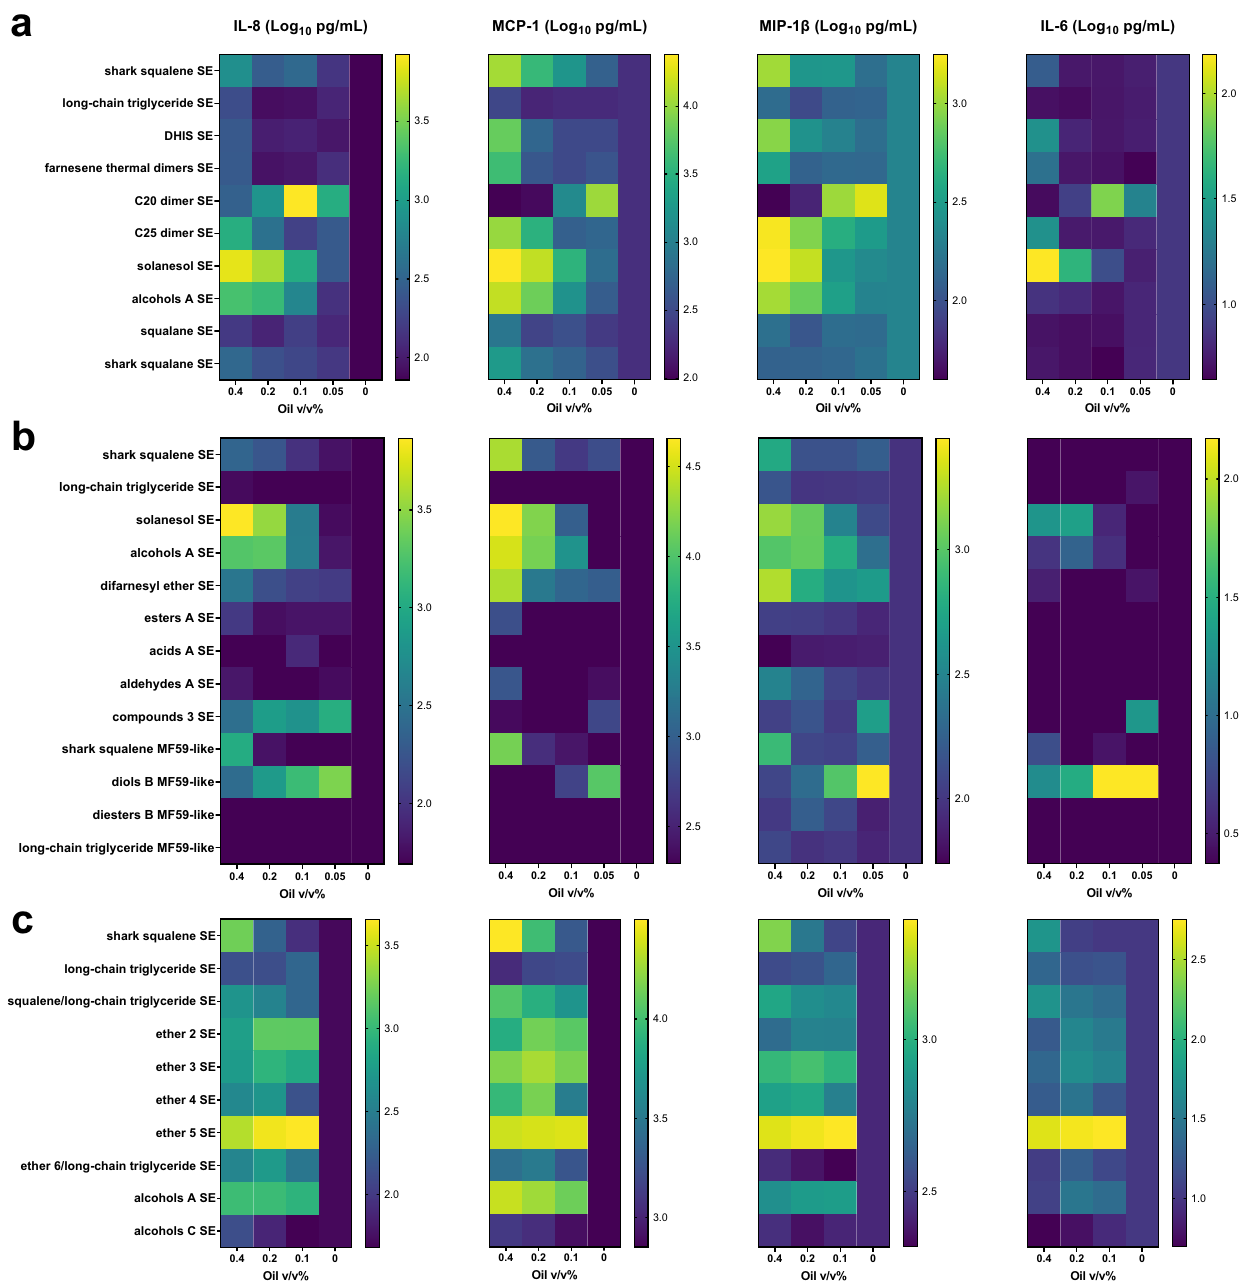
Fig. 2 In vitro stimulation of human whole blood with terpenoid oil emulsions results in differential cytokine activity. Heat map representation of log-transformed cytokine concentrations measured in supernatants of heparinized blood stimulated by incubation with different % v/v terpenoid emulsions or saline alone (represented as 0% v/v oil). The various terpenoid oils were evaluated in comparison to shark squalene emulsion (positive control) and long-chain triglyceride emulsion (negative control). a Cytokine pro fi les elicited by a fi rst set of terpenoid oils. Values represent the mean from 12 donors (six male and six female). b Cytokine pro fi les elicited by a second set of terpenoid oils. Values represent the mean from 6 donors (three male and three female). c Cytokine pro fi les elicited by a third set of terpenoid oils. Values represent the mean from 12 donors (six male and six